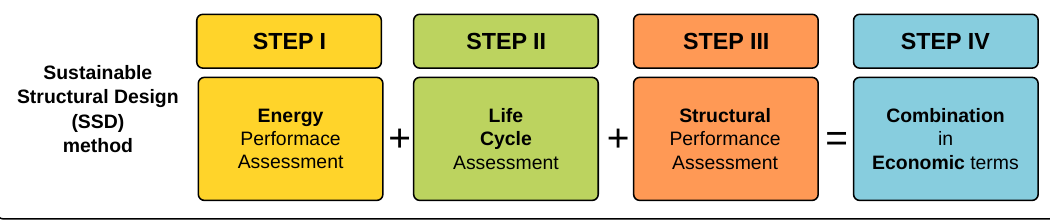
Figure 3. Steps of the SSD